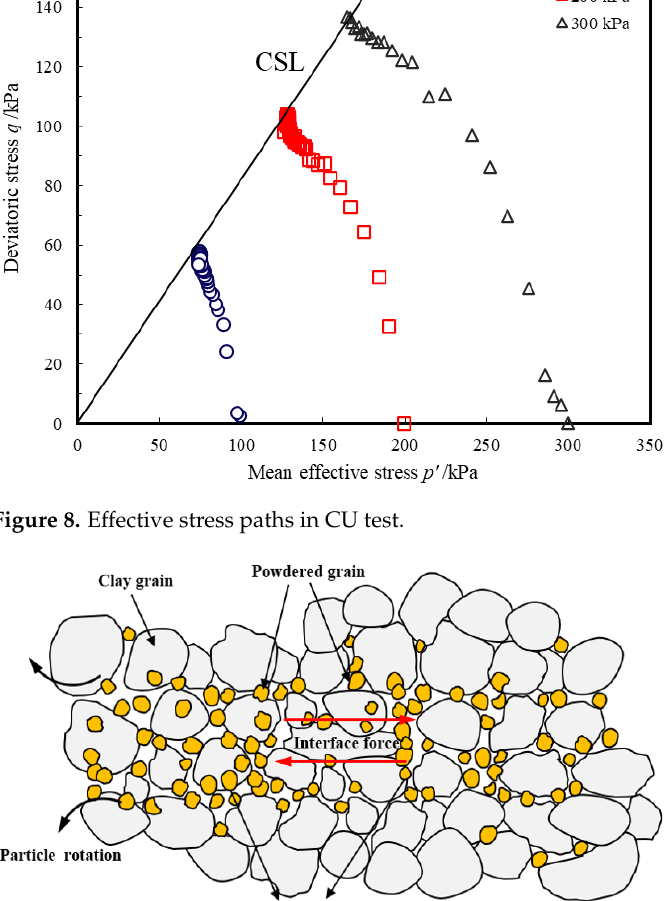
Figure 9. Schematic diagram of the interface mechanical interaction between soil particles.